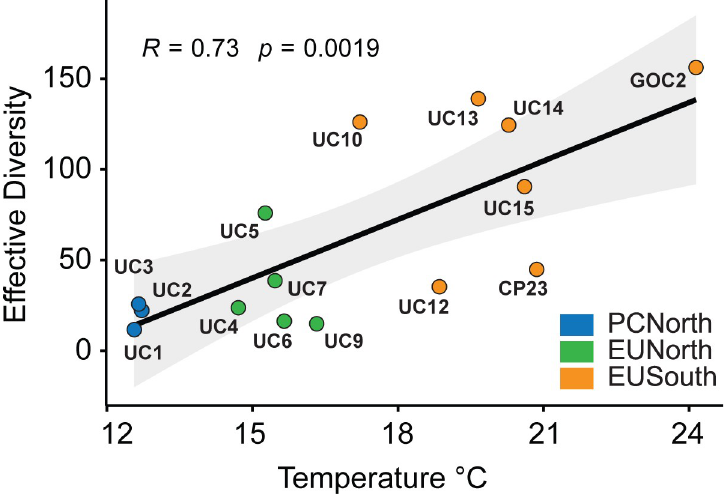
Fig 5. Effective diversity and temperature. Linear correlation between effective diversity and temperature across Banzai COI dataset. Mean diversity value of replicates was taken to represent sites UC3, CP23, and GOC2.